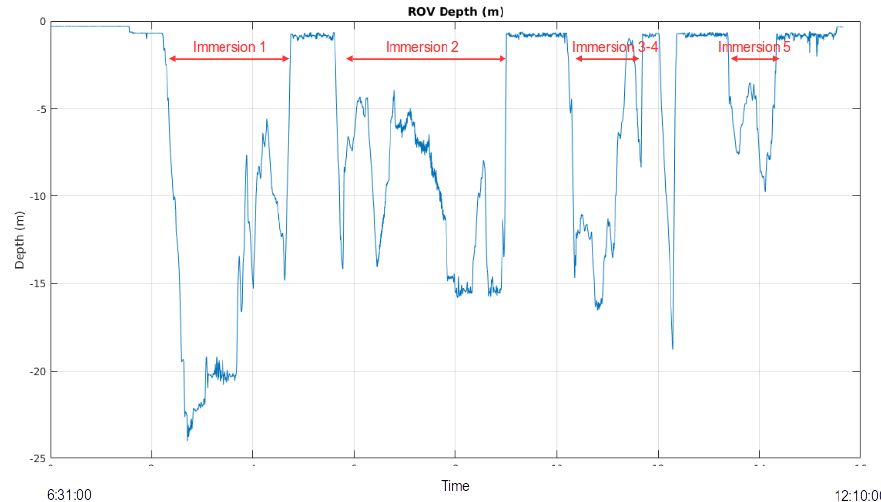
Figure 5. Graph showing the five dives performed by the e-URoPe (horizontal red arrows). The x -axis shows the time (in the format hours, minutes, seconds) and the y -axis shows the depth value of the vehicle with respect to the water surface as measured by the depth sensor of the CTD.